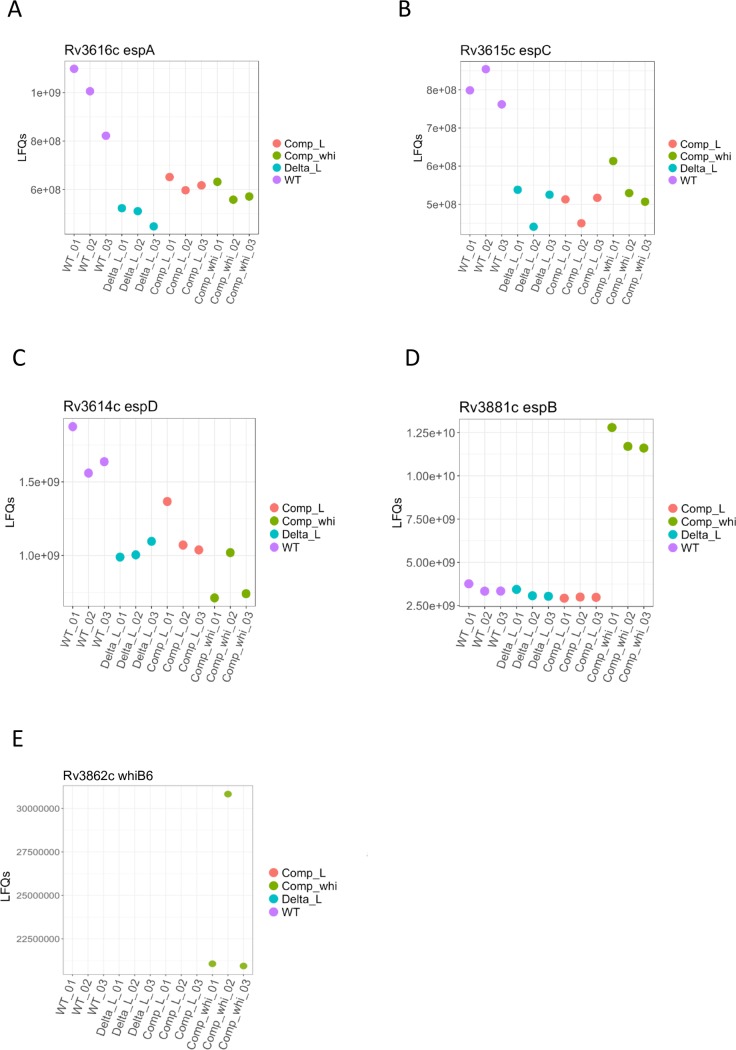
Mass spectrometry analysis of protein abundance in the ΔespL mutant.Total protein extracts were prepared in triplicate and subjected to Mass Spectrometry analysis. Each graph shows the abundance of the indicated protein in the three replicates in the various strains. A) EspA. B) EspC. C) EspD. D) EspB. E) WhiB6. WT: H37Rv. Delta_L: ΔespL. Comp_L: ΔespL/espL (complemented strain). Comp_whi: ΔespL/whiB6 (strain expressing whiB6 in trans). Data are expressed as LFQs (Label Free Quantifications).